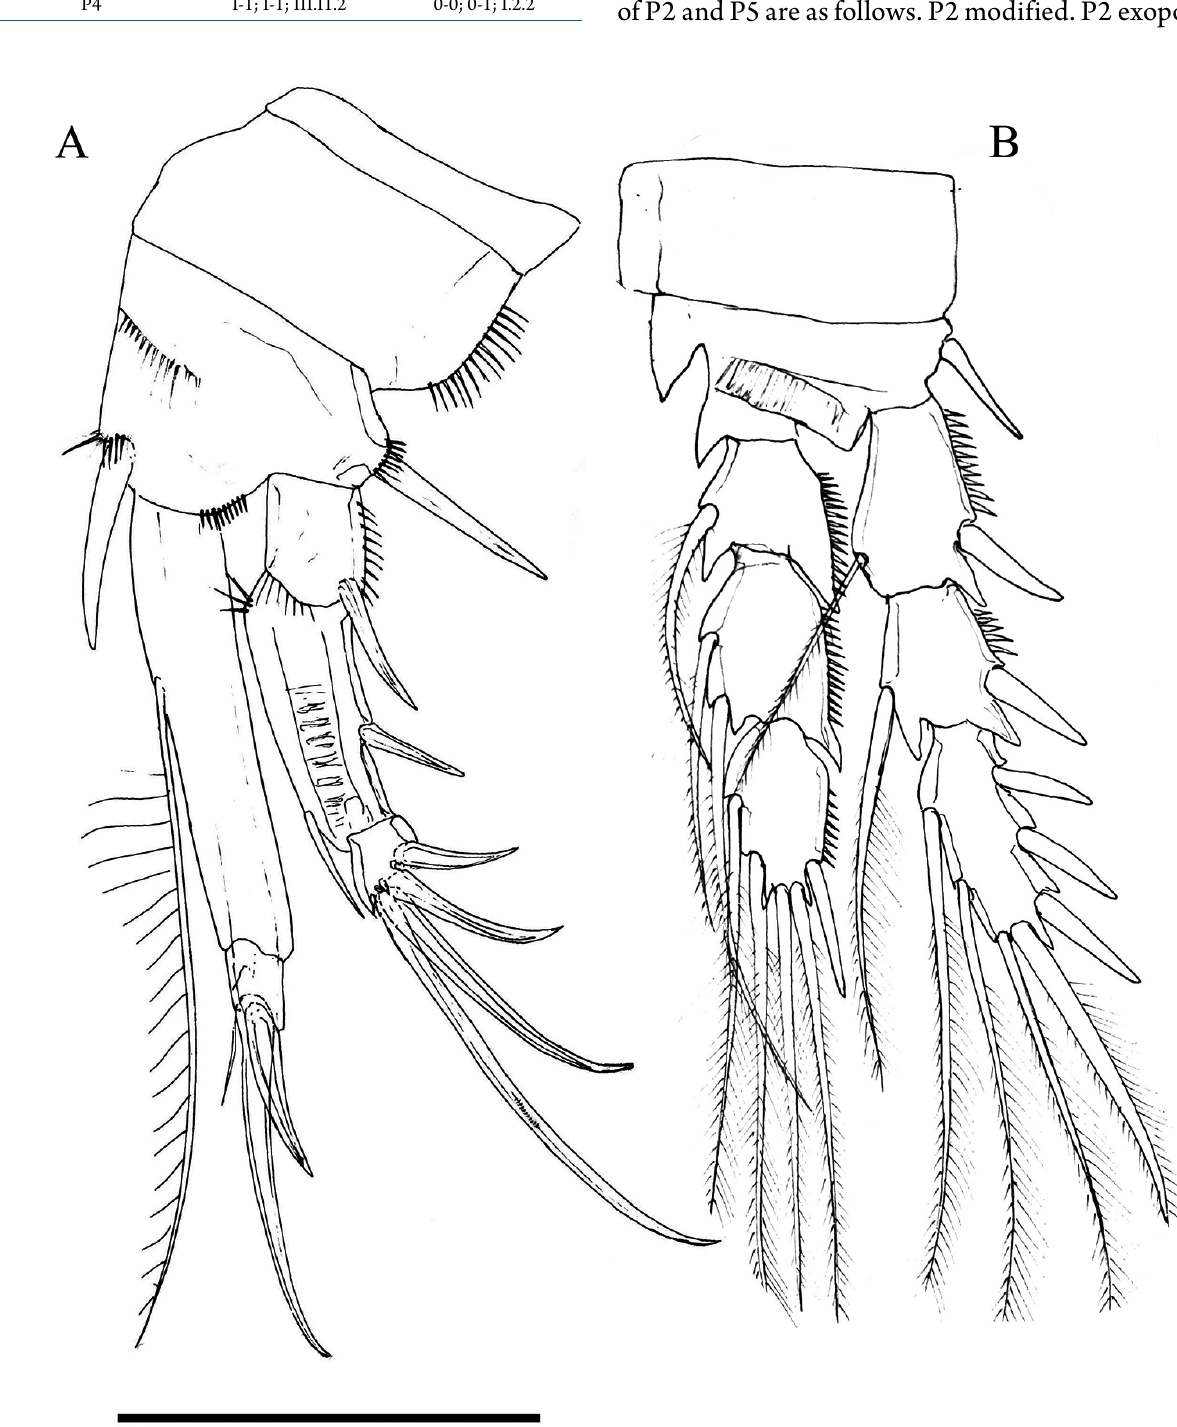
Figure 5. Eudactylopus fasciatus Sewell, 1940, female. A, P1, anterior; B, P2, anterior. Scale bar: 100 µm.